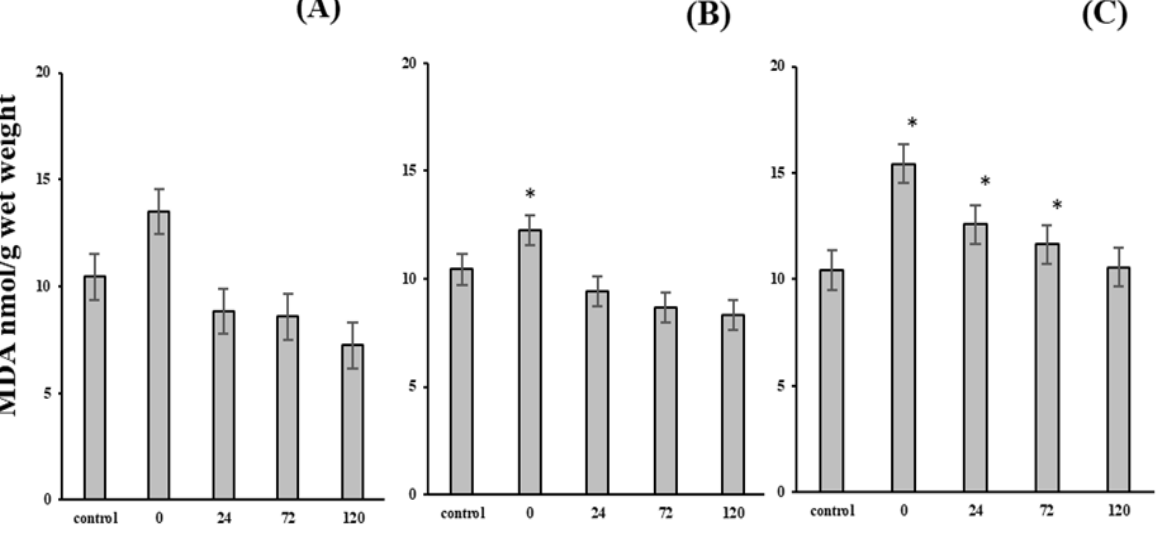
Figure 2. MDA content in the gills of M. trossulus under copper (Cu 2 + ) accumulation conditions and after depuration. ( A – C )—exposure to Cu 48, 96, 168 h, respectively; 0, 24, 72, 120 h—depuration (mean ± standard deviation). * Difference from the control is significant ( p < 0.05).